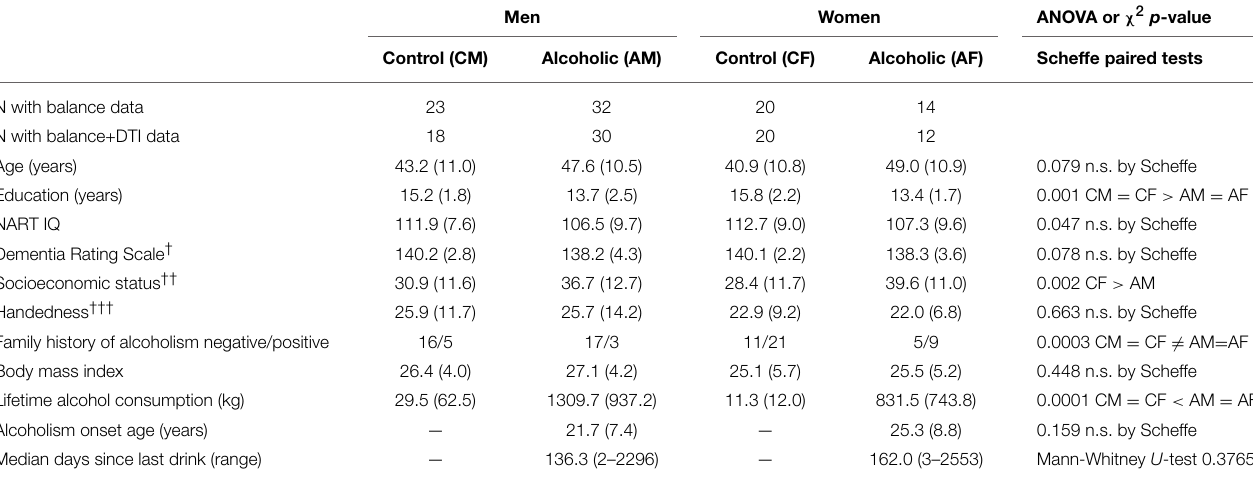
TABLE 1 | Group demographics: mean ( ±